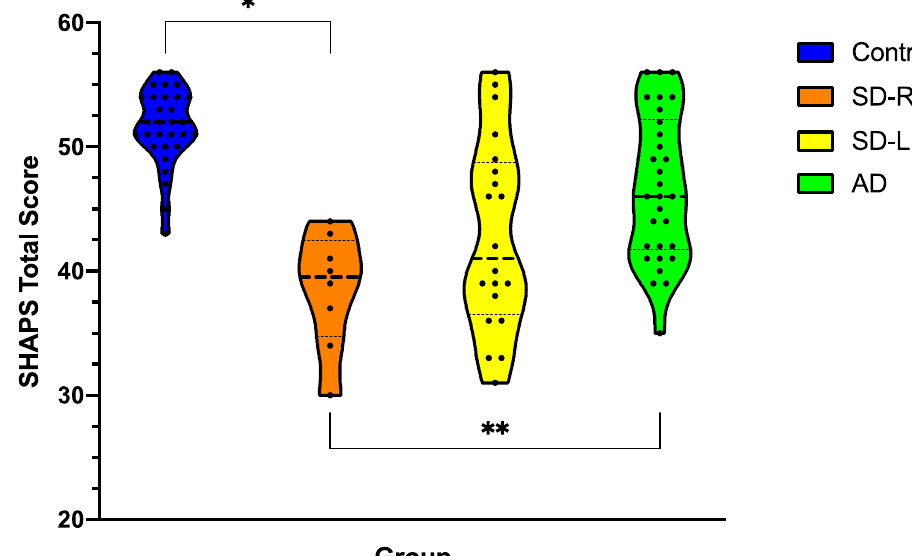
Figure 1. Severity of anhedonia in dementia syndromes at the current time as rated by carers on the Snaith–Hamilton Pleasure Scale (SHAPS) compared to self-rated anhedonia in Controls. Violin plots depict the distribution of data with the width of the shaded area representing the proportion of data located there. Bolded horizontal line depicts the mean score. Maximum score on SHAPS is 56, with lower scores reflecting reduced hedonic tone/greater levels of anhedonia. AD = Alzheimer’s disease ( n = 30); SD-L = left-predominant semantic dementia ( n = 20); SD-R = right-predominant semantic dementia ( n = 8). Asterisks denote results that emerged as significant in the ANCOVA/MANCOVA with ACE-III included as covariate. * p < 0.05; ** p < 0.005.